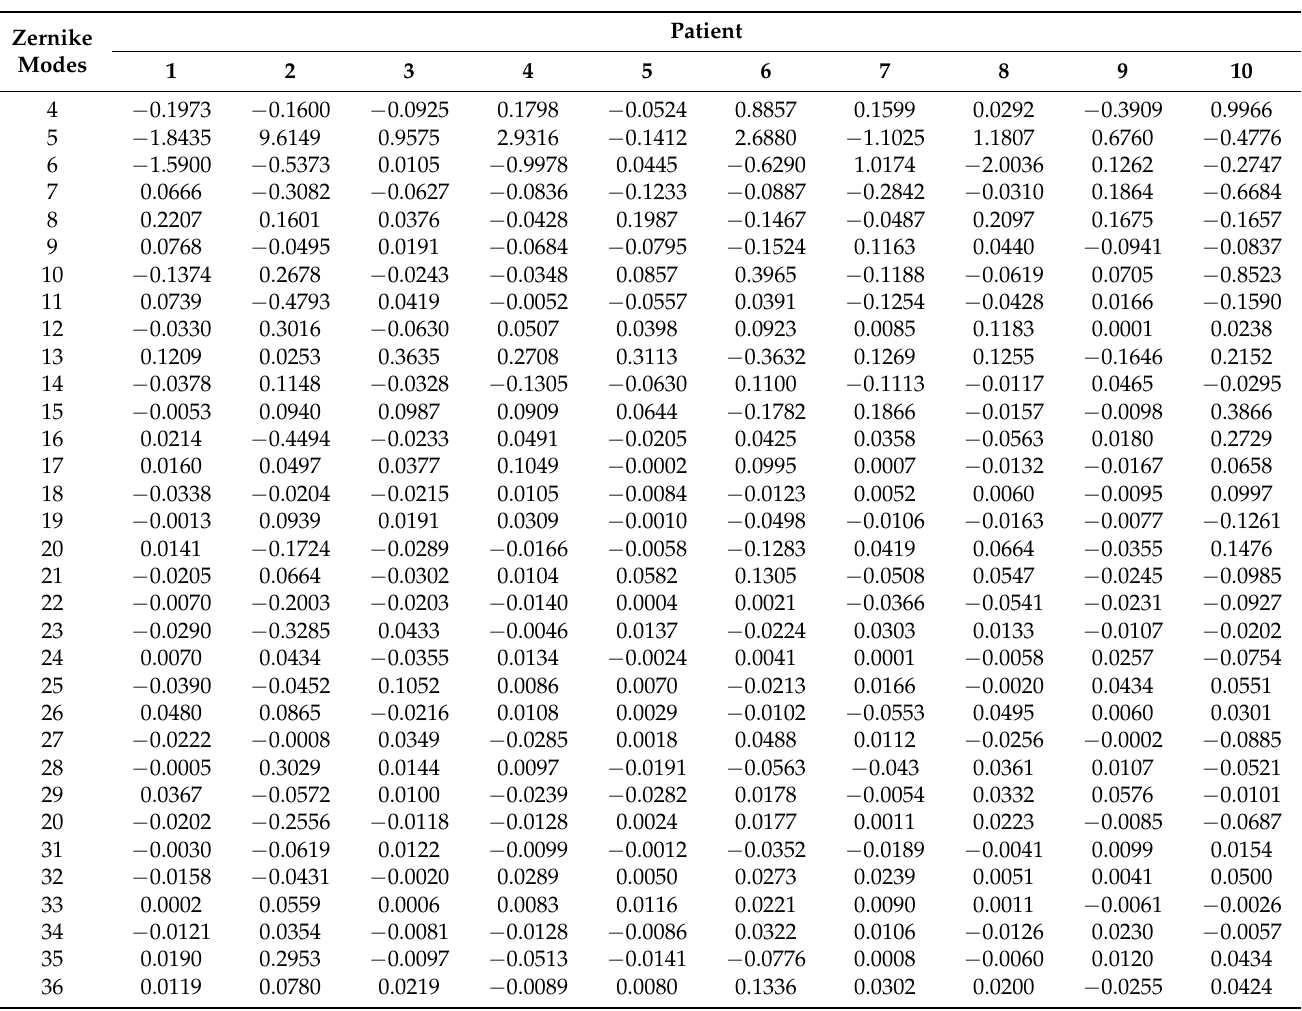
Table A1. The Zernike aberration coefficients of 10 normal human eyes (in µ